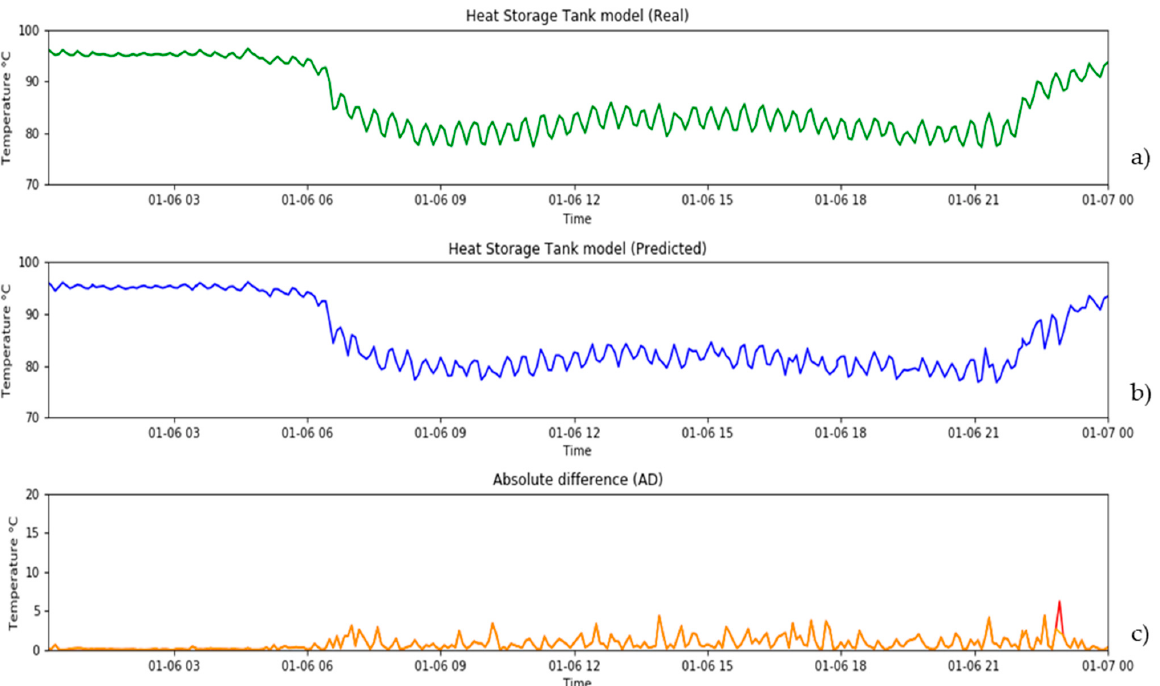
Figure 16. Real ( a ) vs. predicted ( b ) output of the heat storage model within the cascading architecture for the 6 January 2015, along with their absolute difference ( c ) (AD).